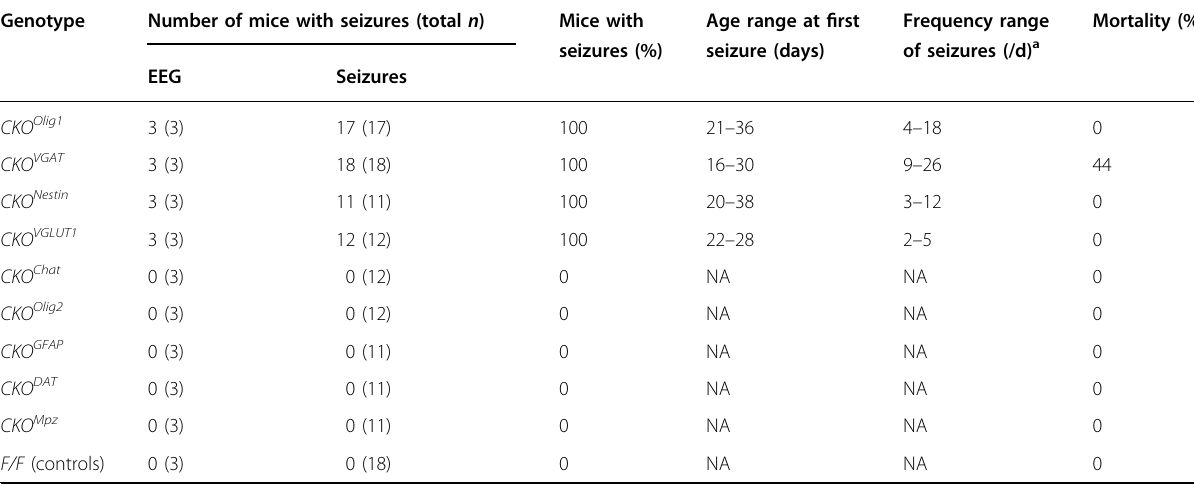
Table 1 Summary of seizure and EEG and characteristics of seizures in multiple CKO mice.